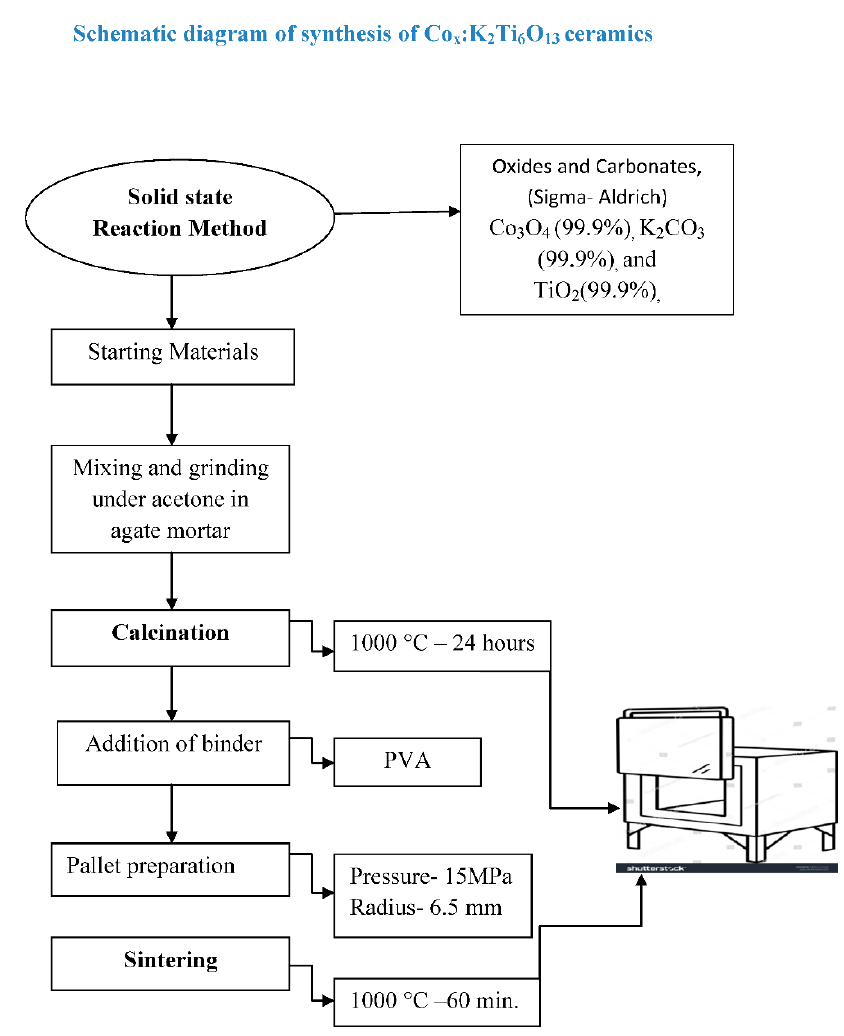
Figure 1. Schematic diagram of preparation of cobalt-doped K 2 Ti 6 O 13.